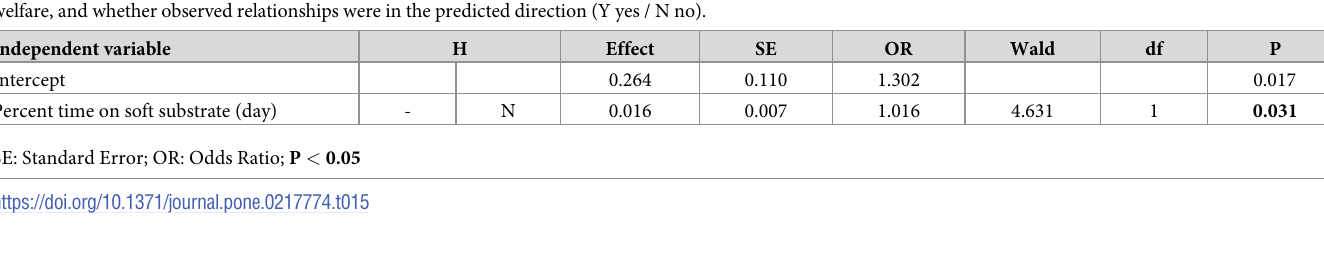
Table 16. Multivariate assessment of the occurrence of foot lesions by binomial regression, counting each animal as having experienced (n = 61) or not (n = 151) this type of pathology. Hypotheses (H): positive (+) or negative (-) relationship of each variable with the occurrence of clinical events per animal as a measure of elephant welfare, and whether observed relationships were in the predicted direction (Y yes / N